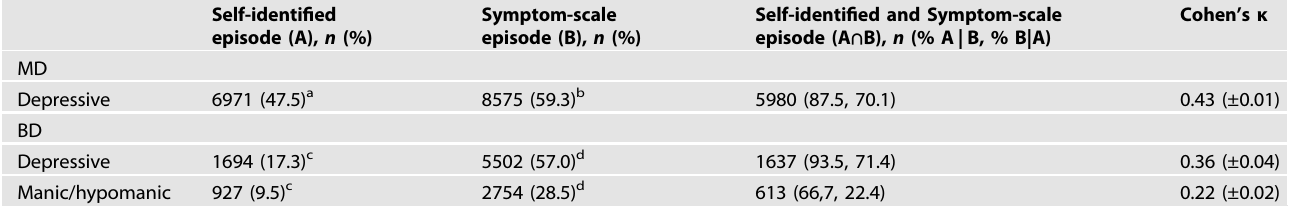
Table 3. Self-identi fi ed episode (i.e. “ Are you currently experiencing an episode? ” , “ What type of episode are you experiencing? ” ) and symptom scale- based episode of cases at